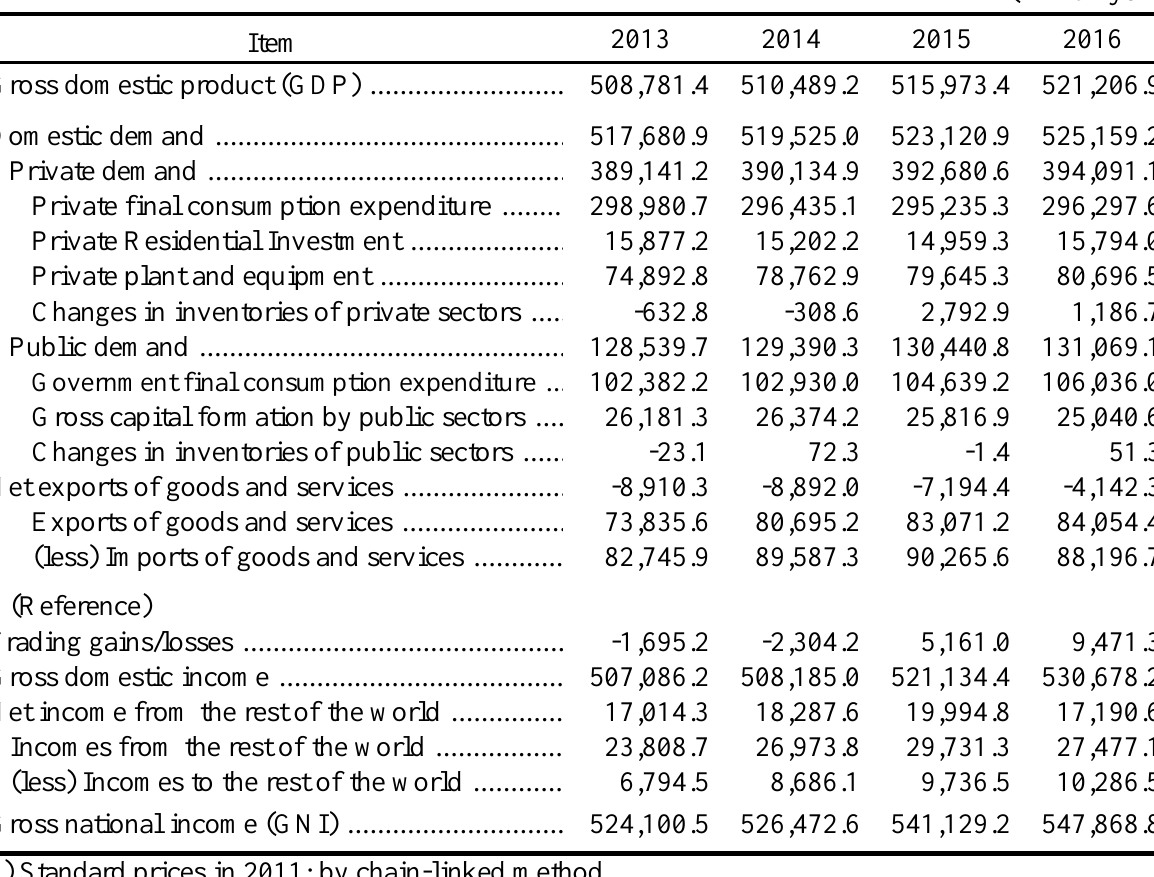
Gross Domestic Product 1) (Expenditure